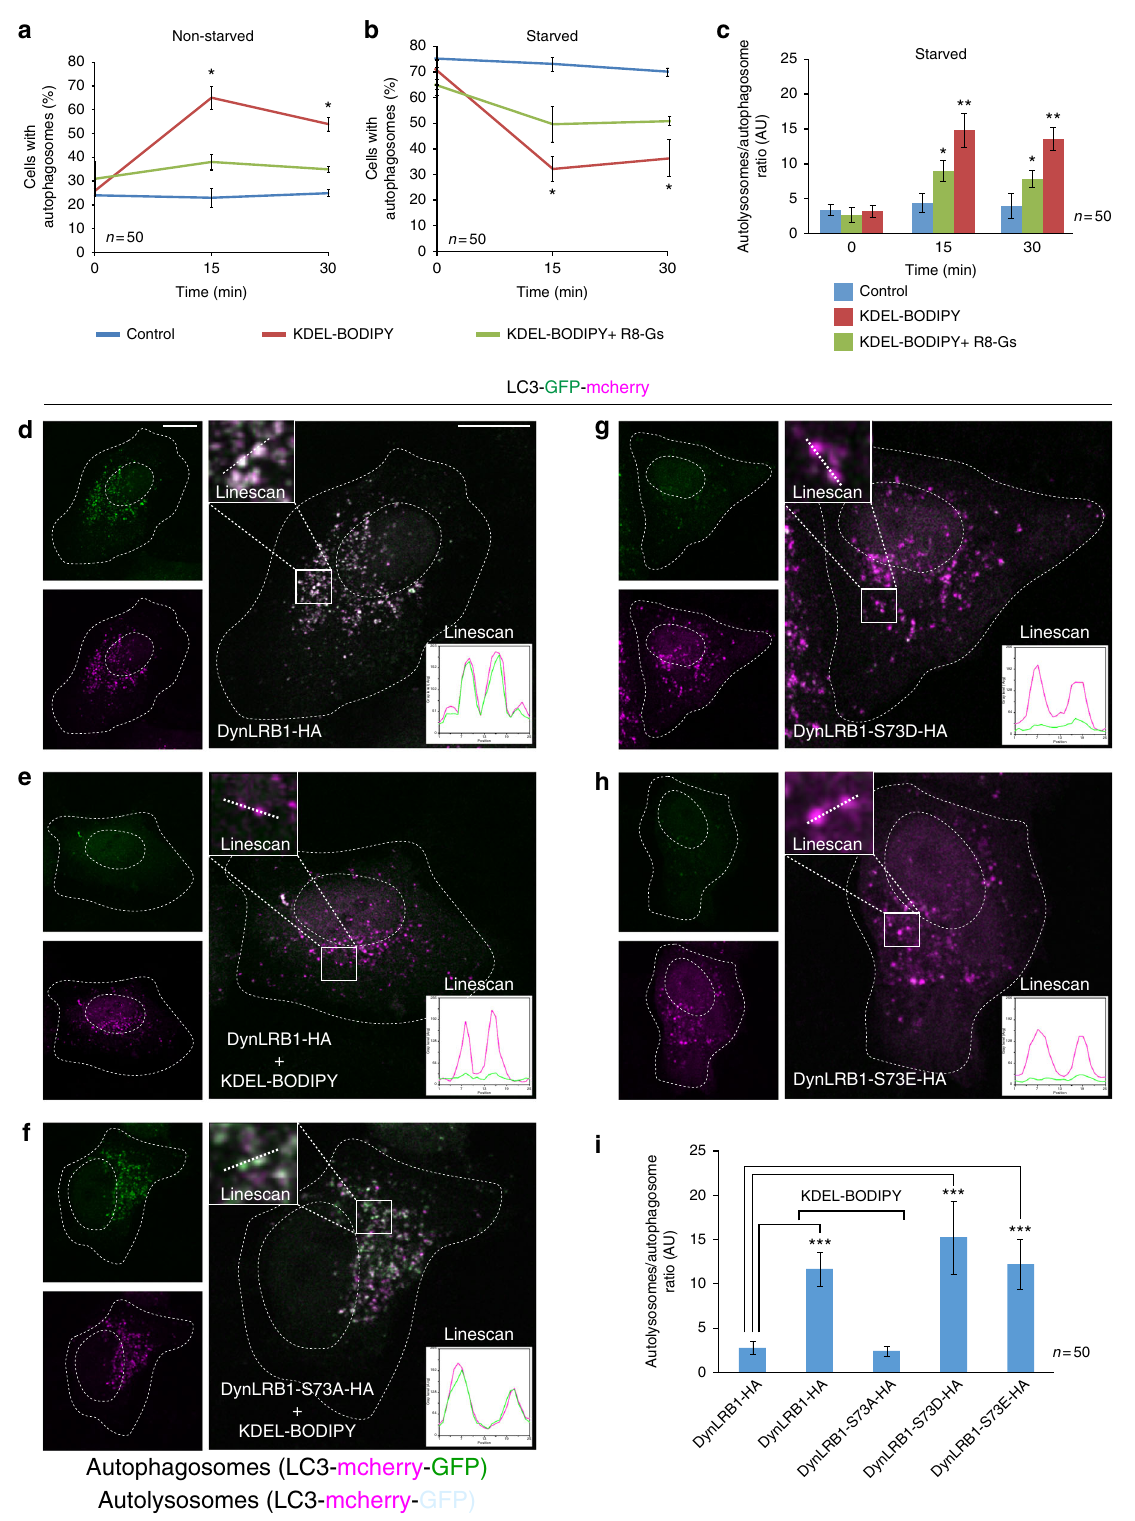
The coordinated response of lysosomes, autophagosomes and the Golgi complex revealed here suggested the possibility of its impact on secretion-mediated physiological processes. To test this hypothesis, we explored its relevance in the secretion of endogenous interleukin-2 (IL-2) during T cell activation. We found that either the blocking of KDELR signalling (Fig. 7e) or